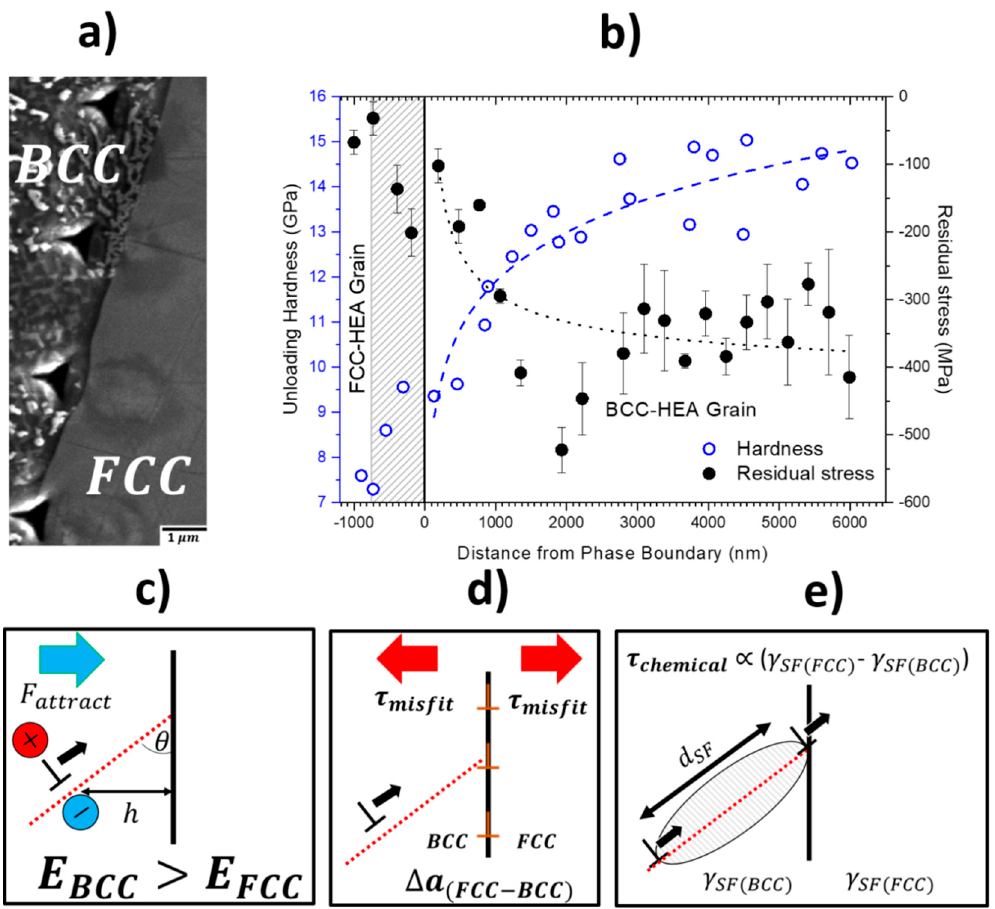
Figure 2. ( a ) BCC–FCC interface in an Al x CoCrFeNi high entropy alloy, with indent profile. ( b ) Variation of hardness and residual stress as a function of distance from phase boundary. The role of image forces is highlighted by local maximum in stress values on the BCC side (attractive image forces) and a local minimum on the FCC side (repulsive image forces). ( c – e ) illustrate different interfacial-dependent strengthening mechanisms. Figure 2b was adapted from [2] with permission from Elsevier, 2018.